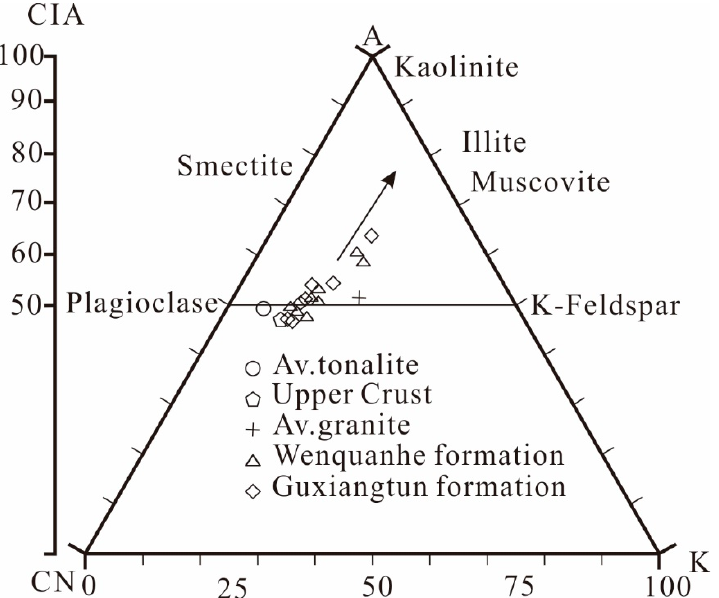
Figure 6. The chemical index alteration (CIA) of the Guxiangyun and Wenquanhe Formations. As discussed in petrography, the detrital grains from the sediments are mainly subangular and subround, and the sediments are poorly sorted. To describe the sorting of sediments, the Th/Sc vs. Zr/Sc plot is adopted (Figure 7). The immobile elements, such as Th, Sc and Zr, have a short residence time in water, and are almost quantitatively transferred into the sediments [29]. For the magmatic rocks, the ratio of log (Th/Sc) vs. log (Zr/Sc) is about 1.93. In contrast, if zircon grains were added into the sediments, this ratio would be decreased steeply. Typically for UCC, the ratio of Th/Sc is ~1 and for gra- nitic rocks, the ratios are still higher. In Figure 7, the sediments are characterized by uniform Th/Sc (1.3–2.5) and slightly variable Zr/Sc (9.6–20.5) ratios. These data suggest that the sandstones were slightly enriched with zircon, indicting sorting during transport.